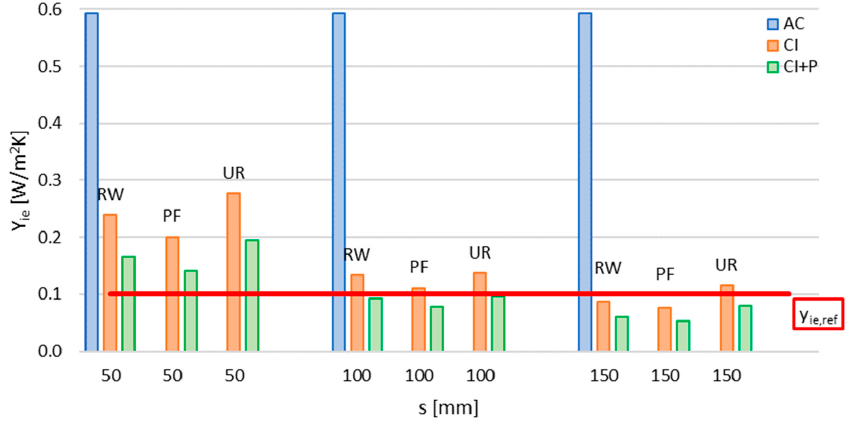
Figure 4. Periodic thermal transmittance Y ie .